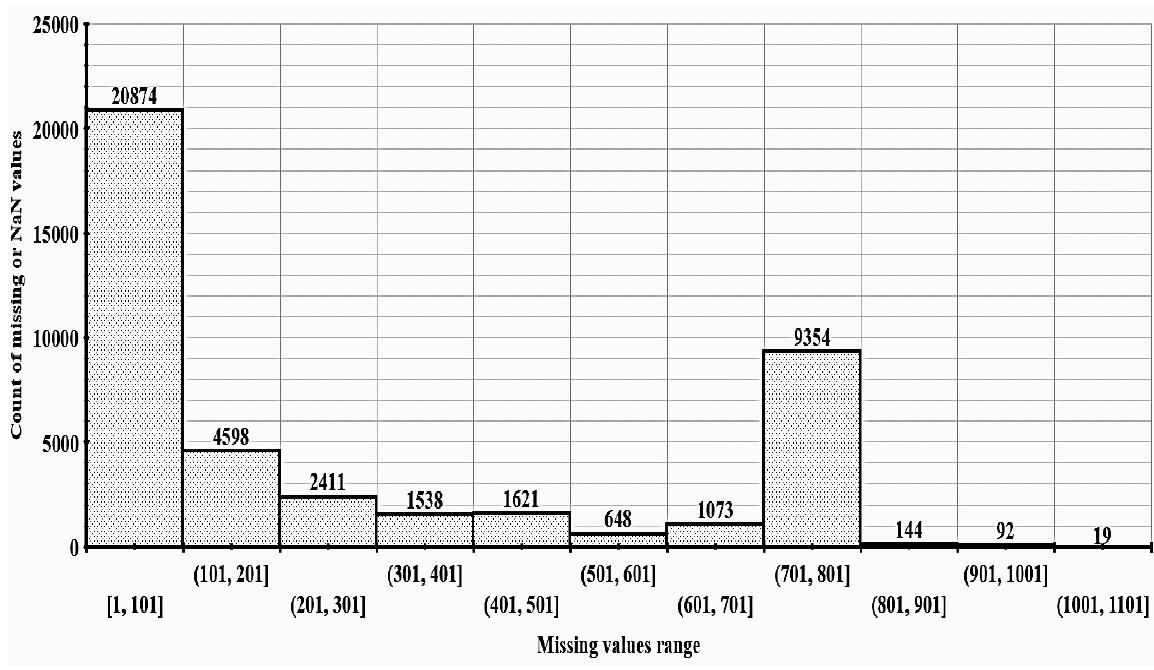
Figure 5. Histogram of missing values present in SGCC dataset.